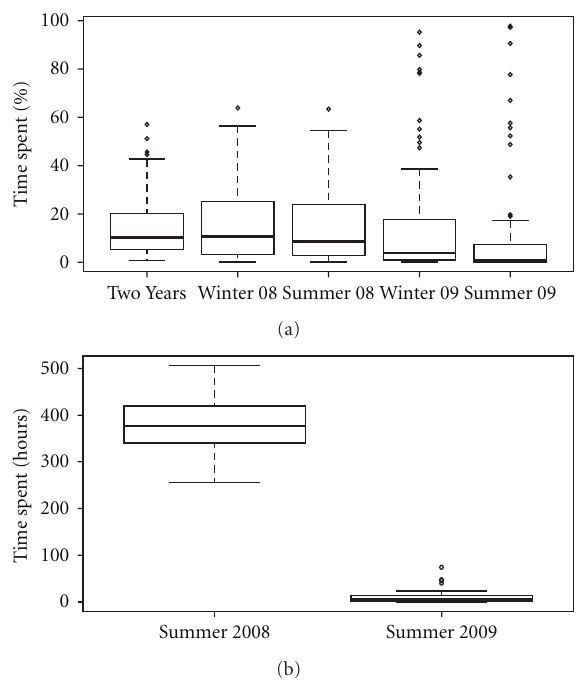
Figure 6: Tukey boxplots of the seasonal and annual variation in the proportion of time spent as a relative Hotspot (a) and total Degree Heating Hours for Summer 2008 and 2009 (b). The rectangle represents the interquartile range (i.e., the 25th percentile, median, and 75th percentile), the “whiskers” represent all values that are within 1.5 times the interquartile range, and the open circles represent outliers, defined as data points that lie outside the whiskers. Paired Welch’s t -tests were used to test for statistically significant temperature di ff erences between seasonal subdatasets. One-tailed tests were used for comparing winter versus summer or two-year versus summer or winter datasets. Two-tailed tests were used for comparing winter versus winter or summer versus summer